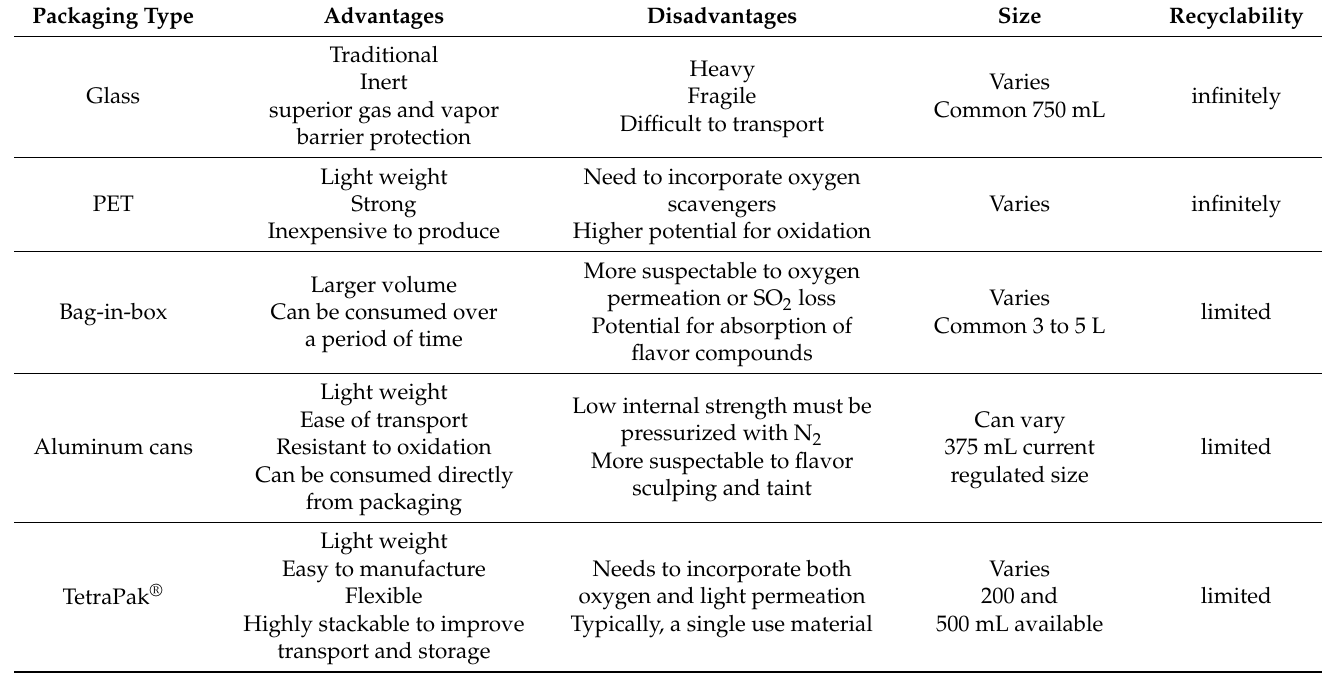
Table 1. A summary table for each of the packaging types discussed. This includes a short description of the key advantages and disadvantages of each packaging type, as well, as the common size and recyclability. Packaging